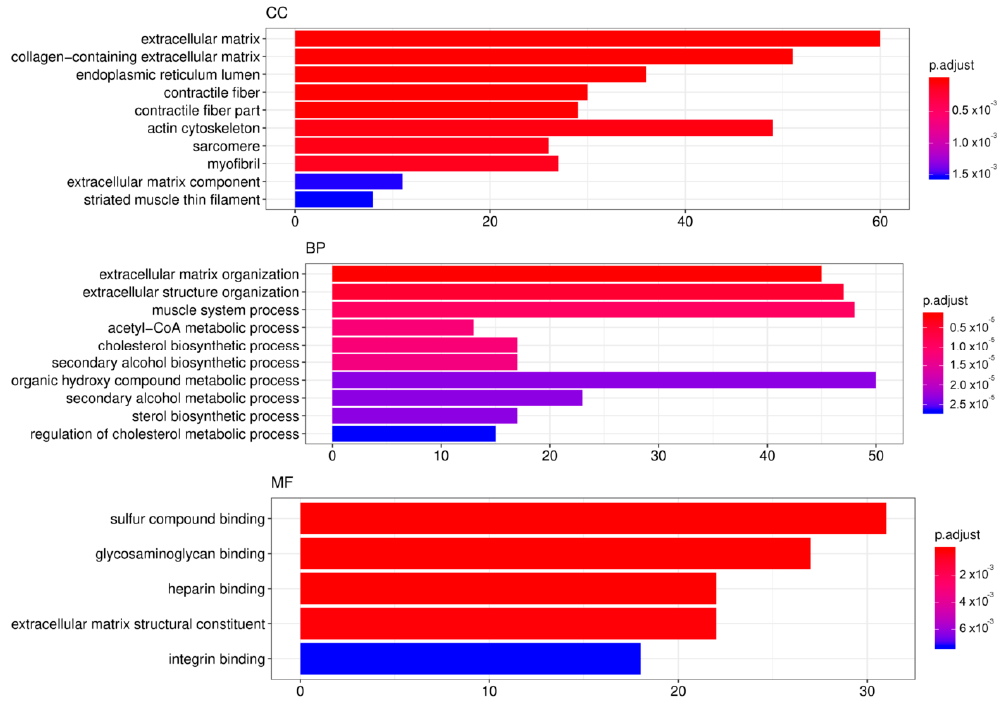
Figure 4. TOP GO categories for biological process, cellular component and molecular function in gene expression modified by SA. Gene ontology (GO) enrichment analysis was performed with DEGs induced by SA administration for 24 h to mRPE cells. The annotated DEGs were classified into the cellular component, molecular function and biological process categories by EnrichGO according to the GO terms. The y-axis shows the functional groups while the x-axis shows the number of genes in each